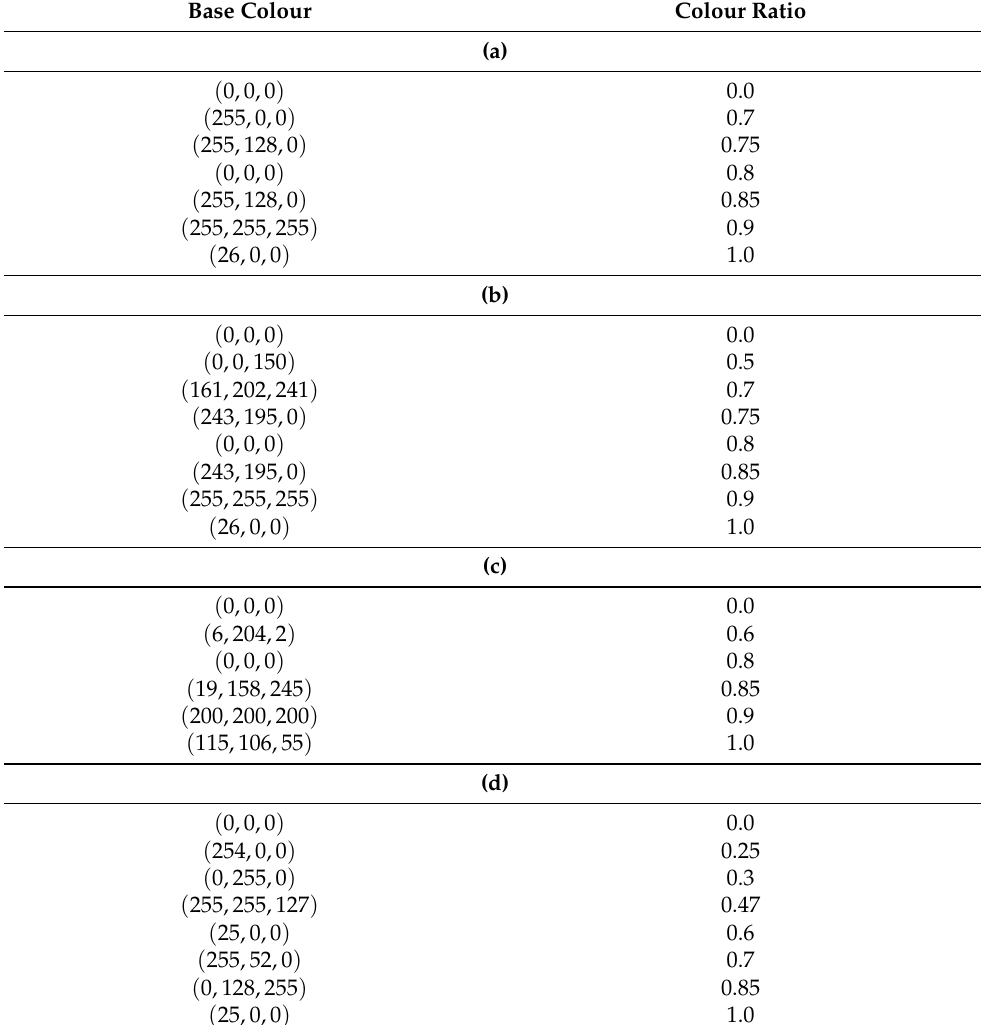
Table 1. Base colours and colour ratios used to generate colour maps in Figure